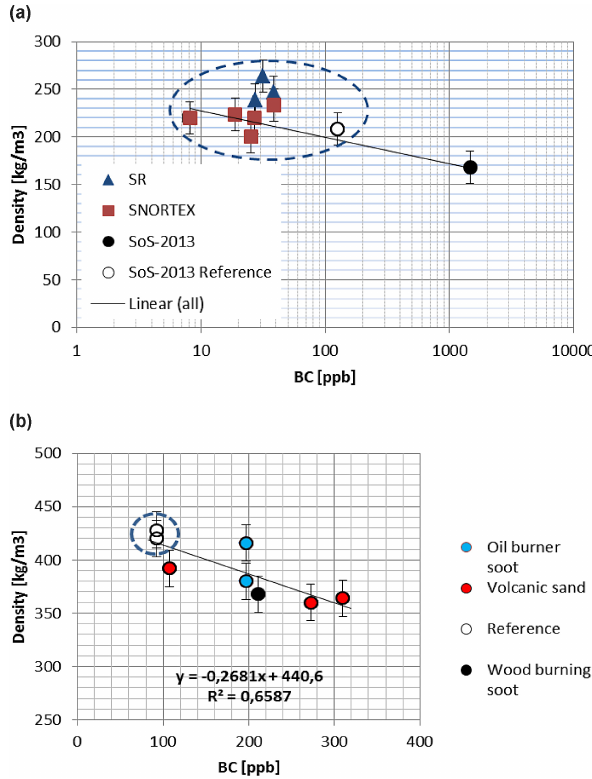
Figure 2. The black carbon (BC) content [ppb] vs. density [kgm − 3 ] for the natural seasonal snow cover in Sodankylä, north of the Arc- tic Circle with and without artificially added impurities. The line is the least squares linear fit through all the points. (a) Cold snow- pack: for natural snow without added impurities, BC concentrations were 8–126ppb, and snow densities were 200–264kgm − 3 and for the reference SoS-2013 spot BC was 126ppb and the snow den- sity was 210kgm − 3 (within the circle); when wood-burning soot was artificially deposited to this SoS-spot, BC in snow was mea- sured to be 1465ppb, and snow density decreased to 168kgm − 3 (outside the circle). (b) Melting snow: SoS-2013 data for reference spots (within the circle), and spots with artificially added impurities of volcanic sand, soot from oil burner and wood burning soot (out- side the circle). The densities and corresponding carbon contents were measured separately for the specified surface layers, not for the entire snow